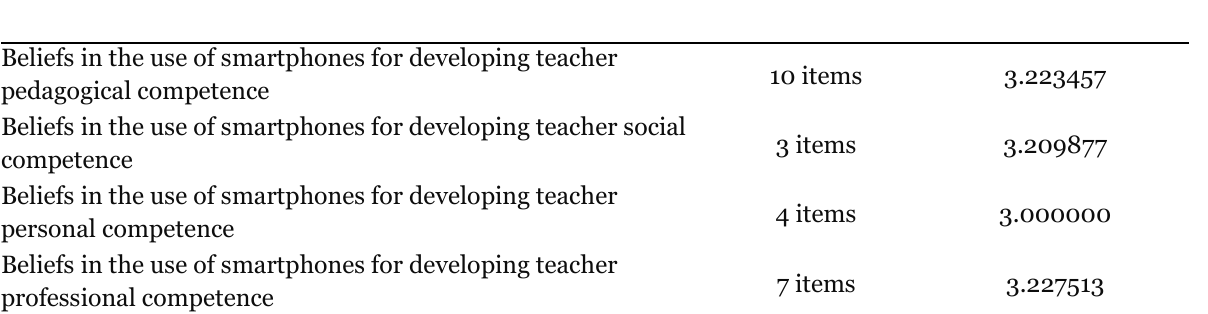
Aspects of teachers’